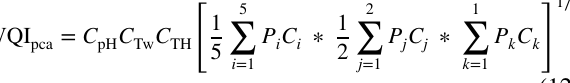
Table 2 The component matrix, eigenvalues, and cumulative extracted PCs